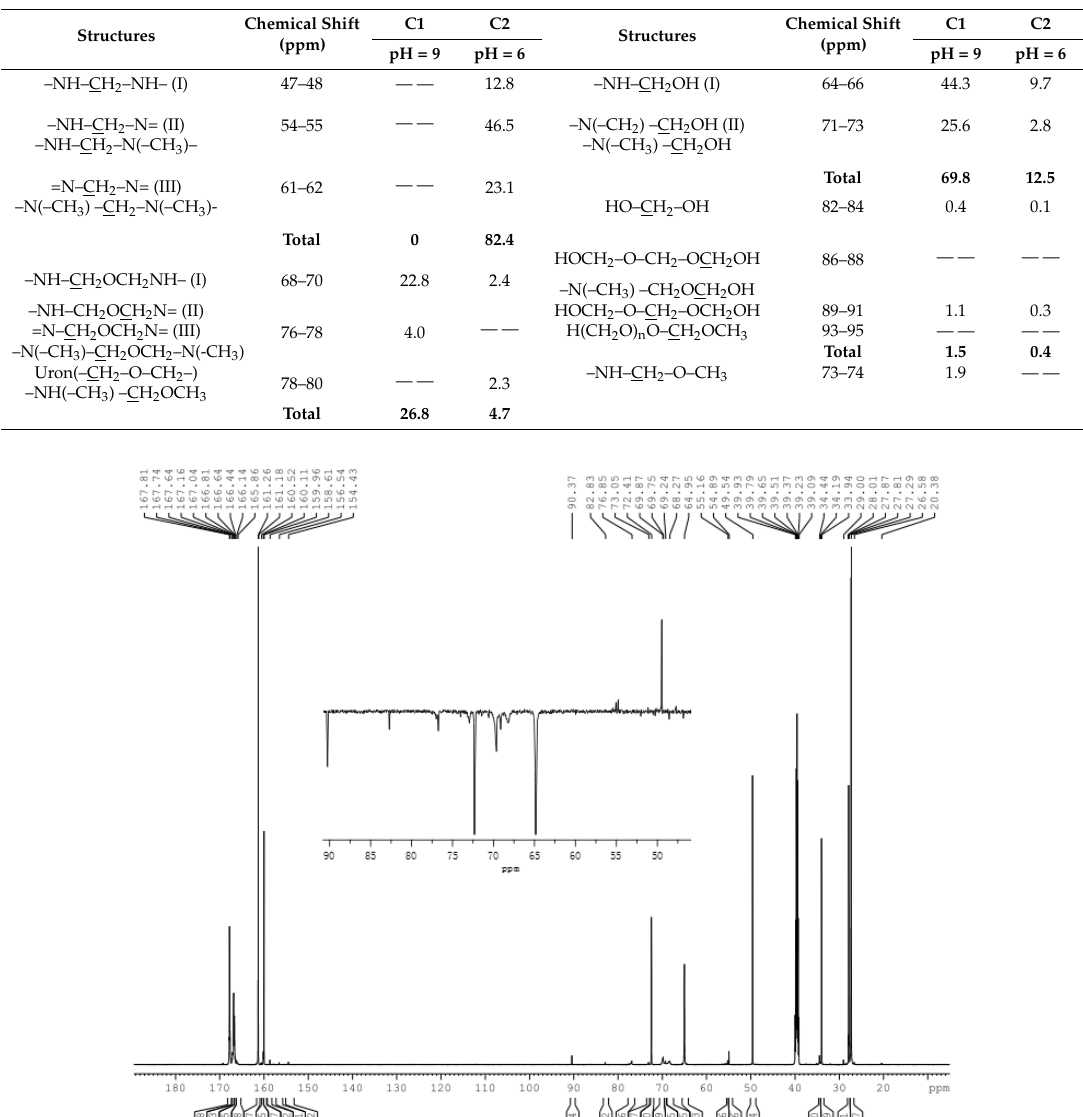
Table 2. 13 C-NMR assignment and quantitative results (%) for MDMUF samples.